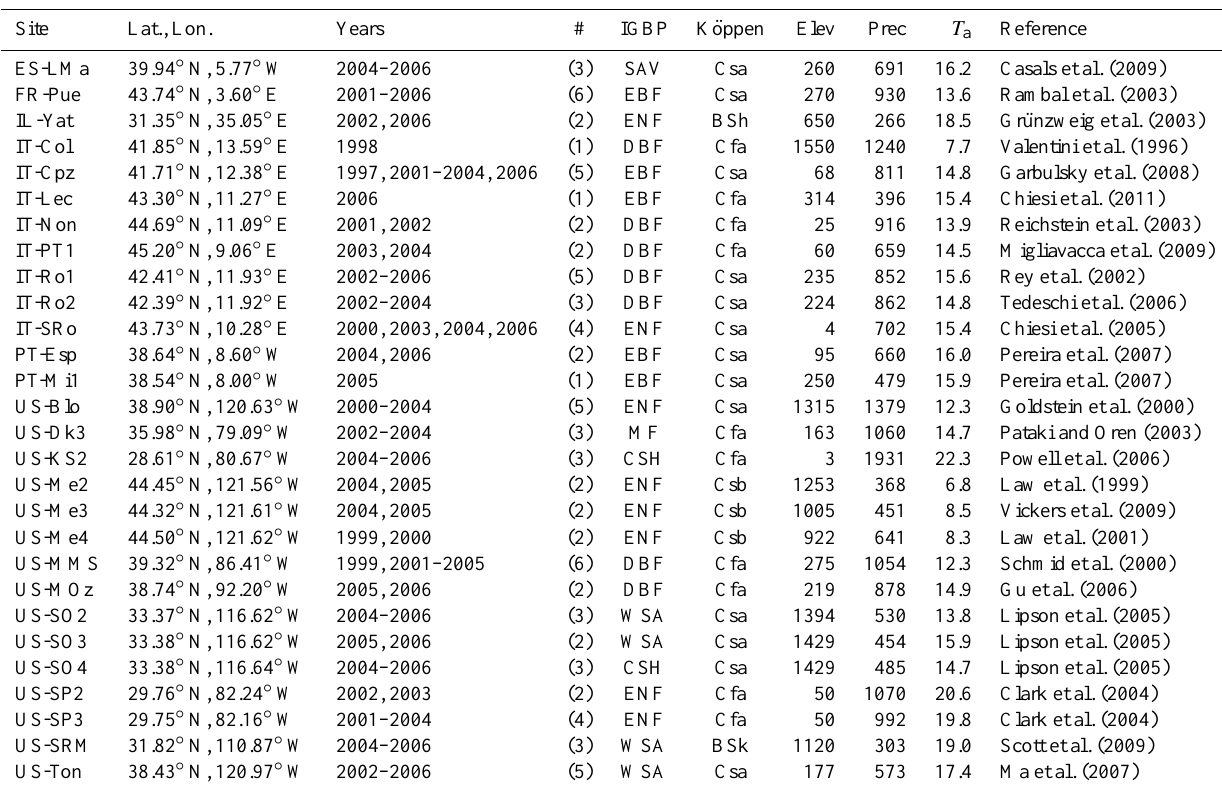
Table 1. Study sites. Shown are FLUXNET site identifiers, site locations, years of data available and count of data site-years for each site, IGBP ecosystem classification (CSH: closed shrubland, DBF: deciduous broadleaf forest, EBF: evergreen broadleaf forest, ENF: evergreen needleleaf forest, MF: mixed forest, SAV: savanna, WSA: woody savanna), K¨oppen climate classification (Kottek et al., 2006; BSh: hot semi- arid; BSk: cold semi-arid; Cfa: humid subtropical; Csa: hot-summer Mediterranean; Csb: warm-summer Mediterranean), site elevation (m),